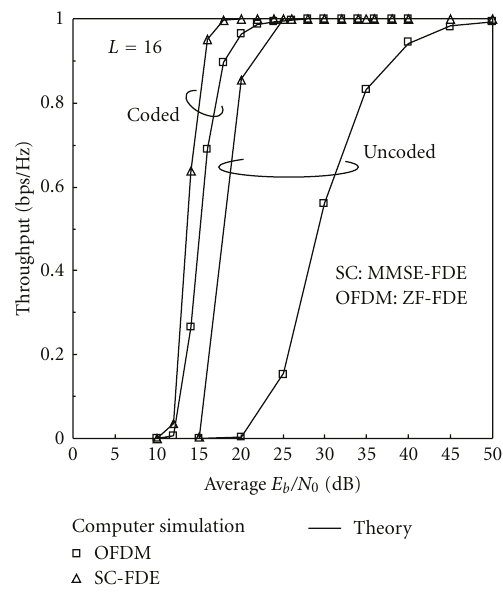
Figure 4: Throughput versus E b /N 0